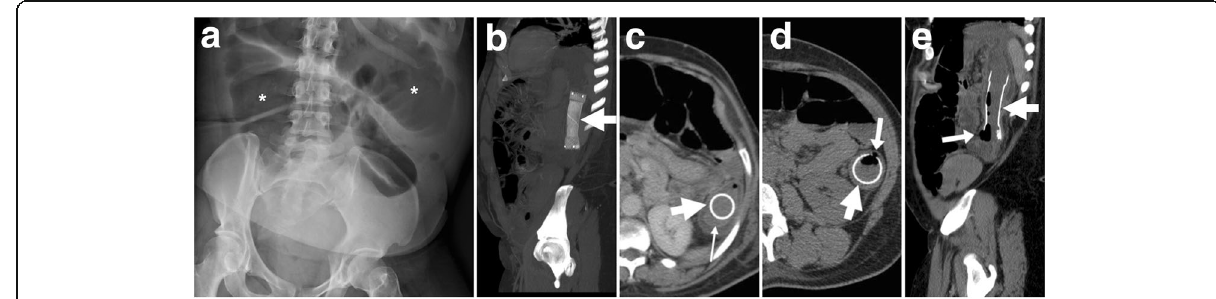
Fig. 16 Haemorrhage and impending stent-related perforation. Initial radiograph ( a ) showing marked colonic dilatation (*). After early clinical improvement, the patient experienced haematochezia. MIP CT image ( b ) confirmed correctly placed and expanded SEMS (thick arrows) at the descending colon. CT images showed some hyperattenuating fresh blood (thin arrow in c ) in the bowel lumen and a gas bubble (arrows in d and e ) piercing through the colonic wall at the distal end of the SEMS. Emergency laparotomic surgery (left hemicolectomy with primary anastomosis) was required